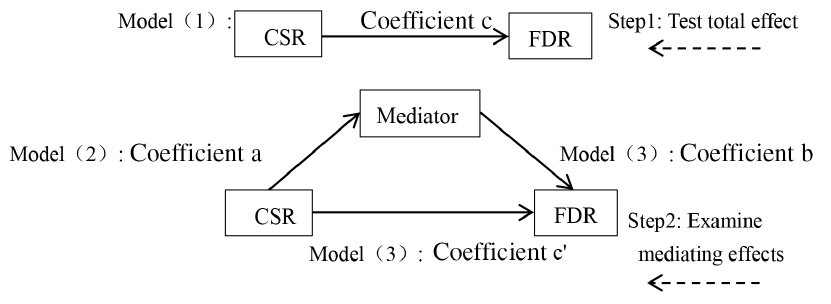
Fig. 1 Mediation effect testing